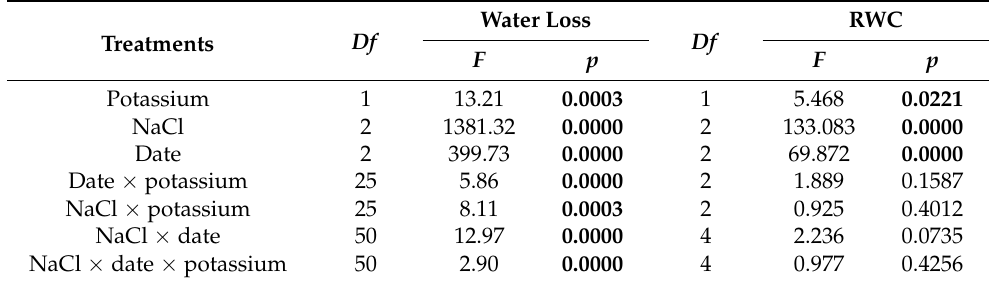
Table 2. ANOVA results for water loss from containers and relative water content (RWC) in zinnia leaves exposed to salinity with two potassium levels in the peat